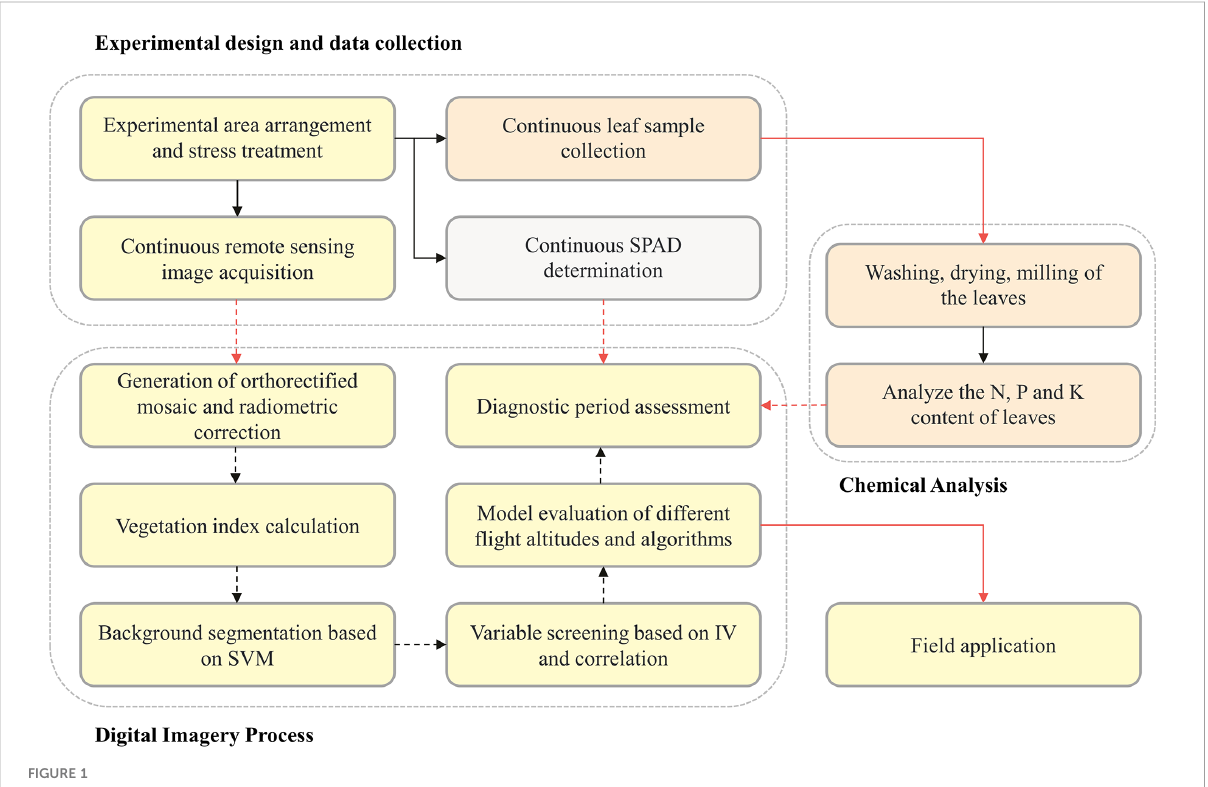
FIGURE 1 Work fl ow of the process performed in this